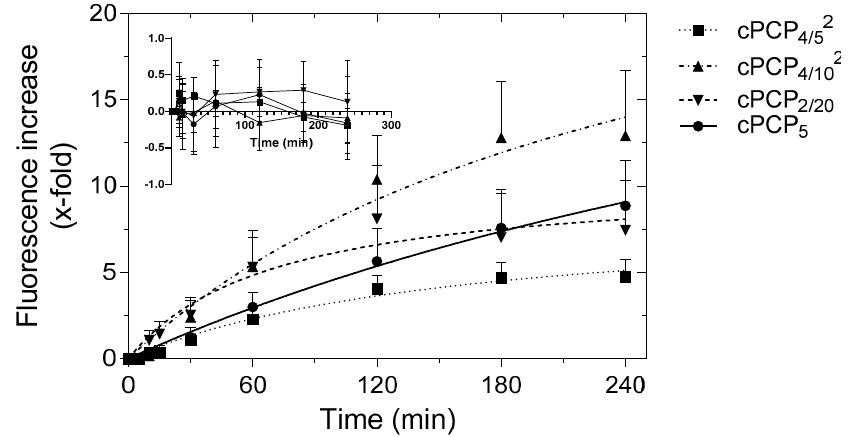
Figure 3. Fluorescence time profiles of different DOX-containing RAFT scaffolds upon the enzymatic cleavage by Cat B from human placenta. Fold increase in fluorescence at different time points is expressed as a ratio of fluorescence emission at the observed time point and fluorescence emission before the enzymatic digestion occurred ( n = 3). Inlet: fluorescence increase (X-fold) without enzymatic activation.